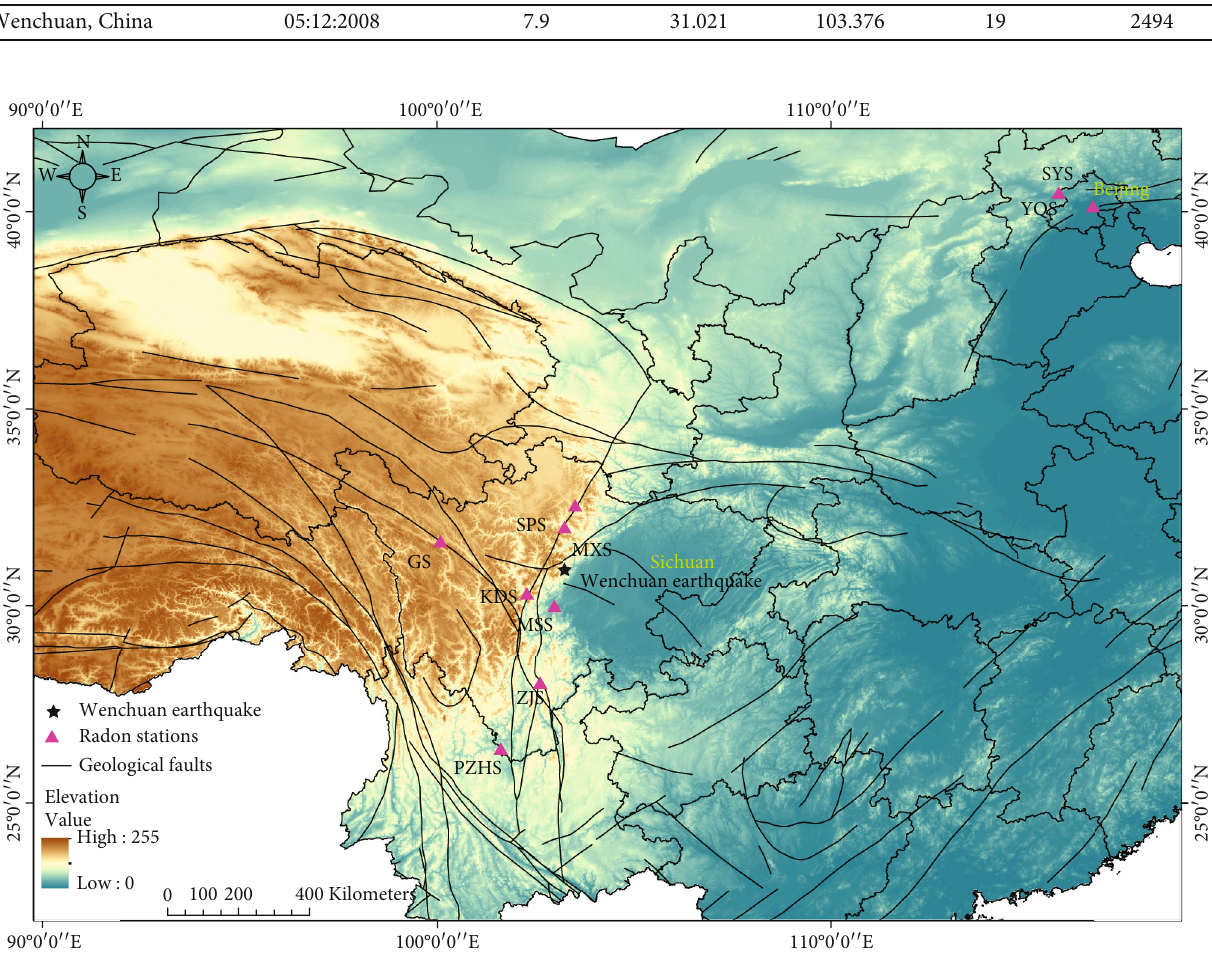
Figure 2: Regional tectonic map of China along with the location of the Rn monitoring stations and major faults. The black star shows the location of the Wenchuan earthquake